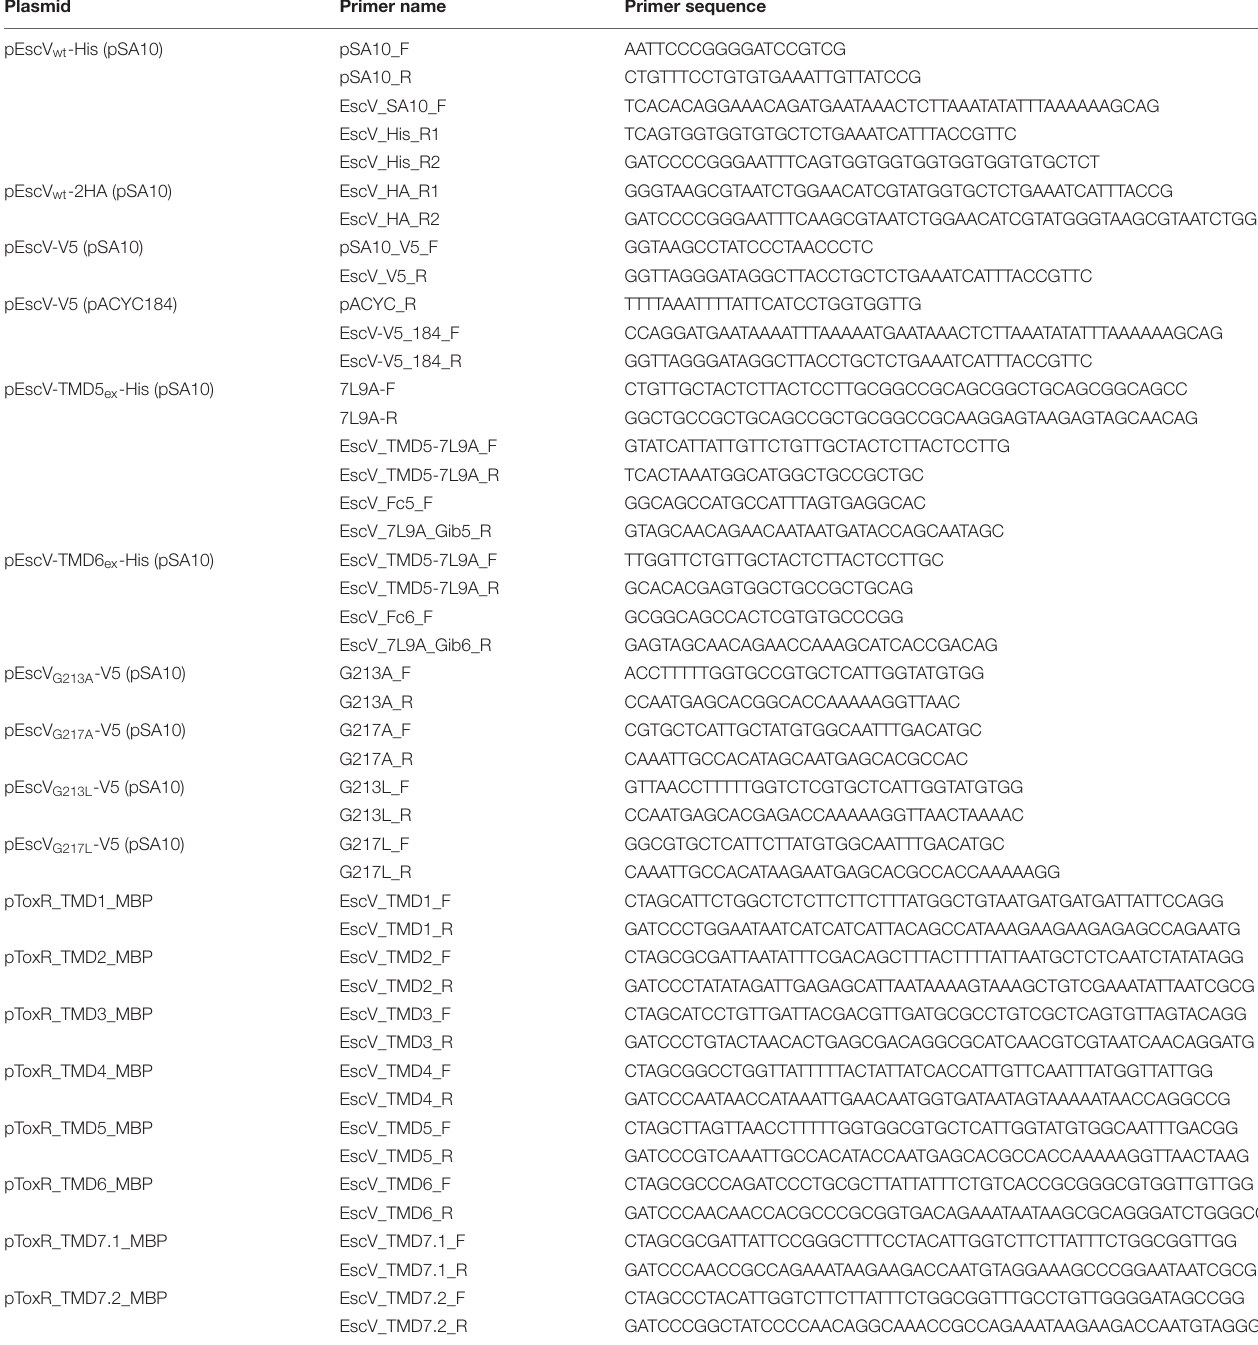
TABLE 2 | Sequences of primers designed and used in this